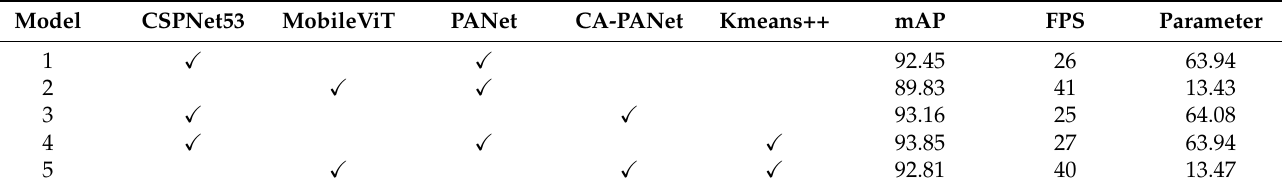
Table 6. The ablation experiment based on